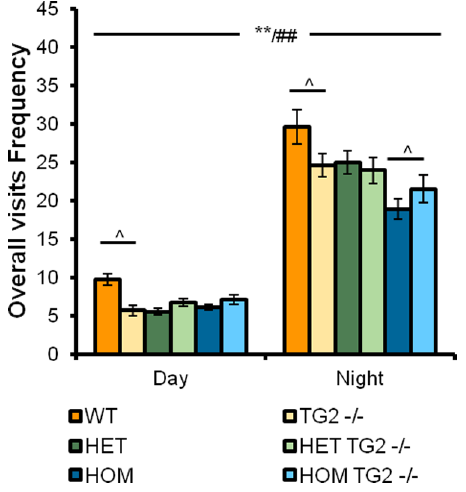
Figure 4. Overall visit frequency detected in the PhenoCube system as a function of genotype, age and light cycle phase in animals from the zQ175 6 TG2 KO line. *Significant HD genotype differences regardless of the light phase (in the mean path length the differences were detected between HET and WT animals); ## significant differences due to light phase in the cycle independently of genotype; ‘ significant TG2 genotype differences (see results method for details). WT: wild-type, TG2 2 / 2 : homozygous TG2 knockout, HET: zQ175 HET, HOM: zQ175 HOM.